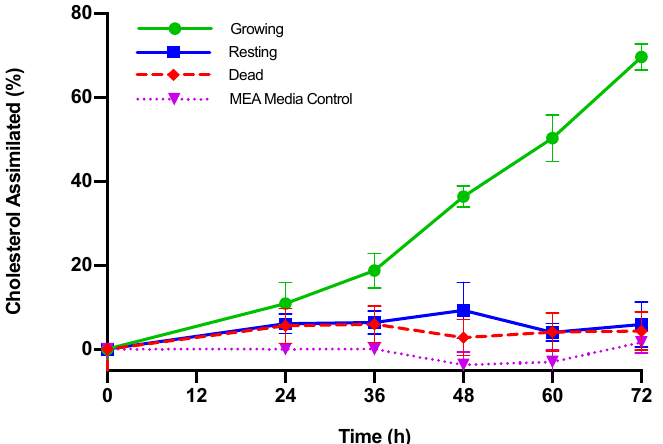
Figure 1. Cholesterol assimilated (%) by M. purpureus CBS 109.07 at different growth phases. Growing, resting, and dead M. purpureus cultures were incubated with 120 µg/mL cholesterol and 0.3% ( w / v ) oxgall bile salts at 37 °C. Malt extract media (MEA) control contained 120 µg/mL cholesterol and 0.3% ( w / v ) oxgall bile salts incubated without M. purpureus . Three independent trials were conducted for each condition at each time point, and cholesterol in samples were measured in duplicate via GC-FID. Standard deviation in cholesterol assimilated is percent error.